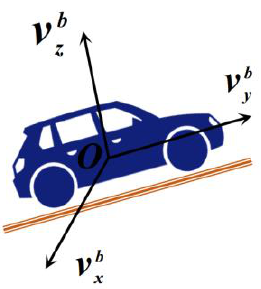
Figure 3. Lateral and vertical velocity in body coordinate system.